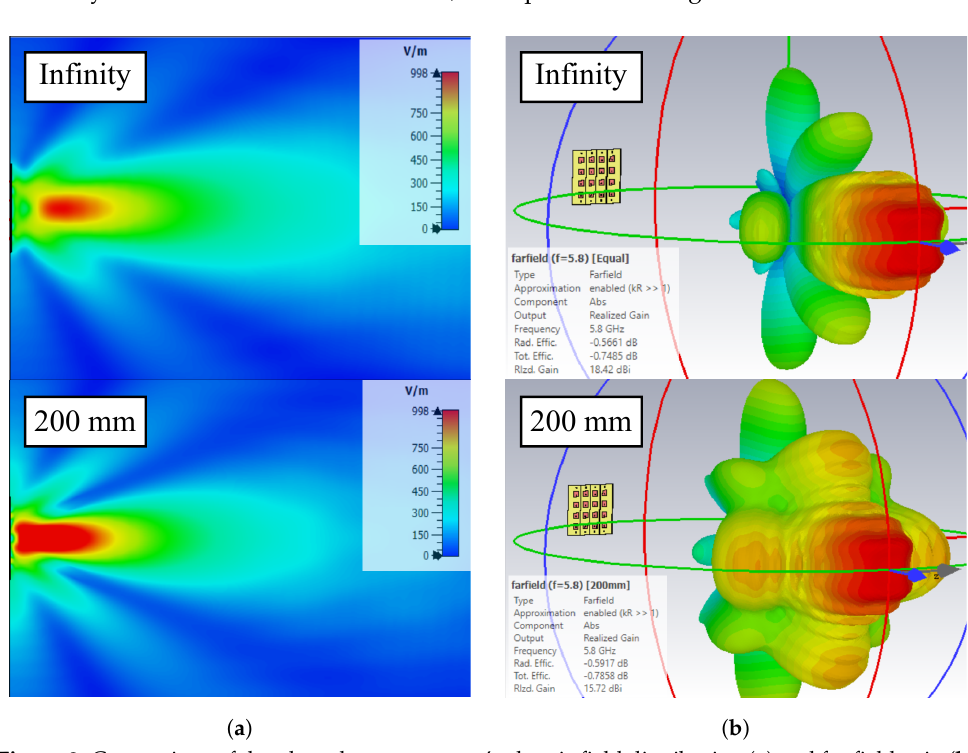
Figure 9. Comparison of the phased array antenna’s electric field distribution ( a ) and far field gain ( b ), for a focus at infinity and at 200 mm from the antenna. The results are summarized in Table